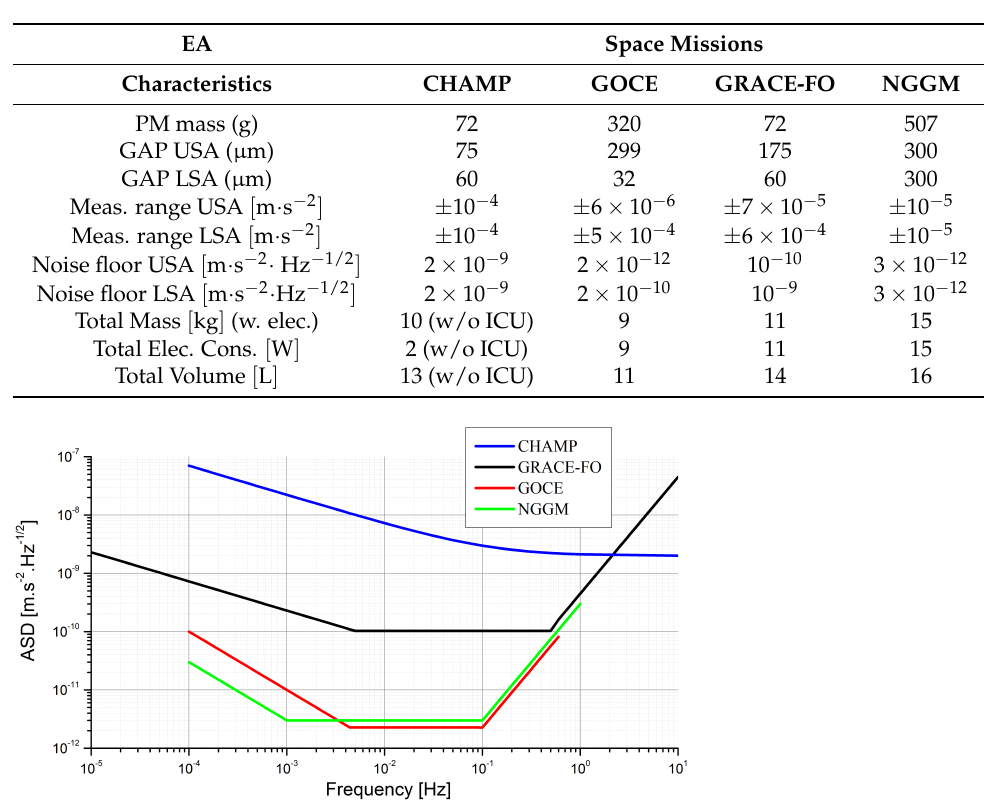
Table 1. Main characteristics of the last flying space EAs in CHAMP, GOCE, and GRACE-FO and the foreseen EAs for NGGM, the future ESA mission. For CHAMP, the mass and power consumption do not take into account the interface and control unit (ICU). USA and LSA stand, respectively, for ultra-sensitive axis and less-sensitive axis. For instance, in GRACE-FO, the USAs are the along-track and radial axes and the LSA is the cross-track axis.